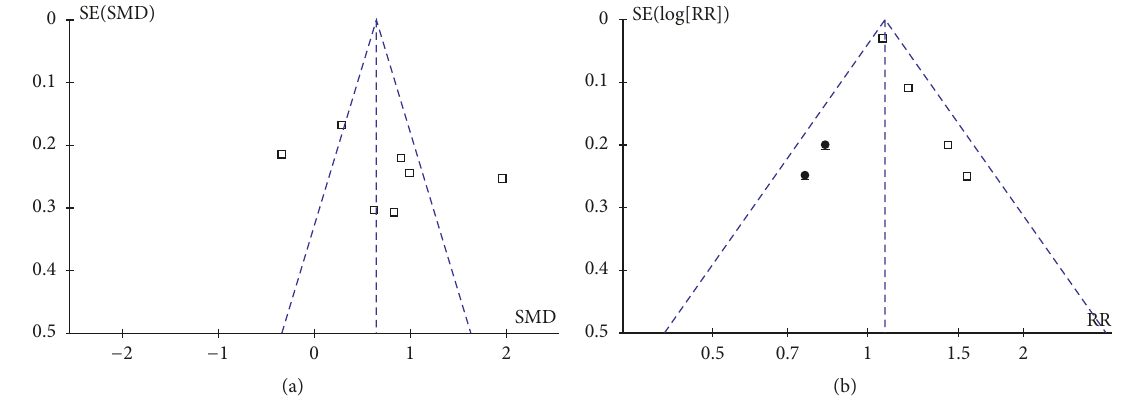
Figure 3: Funnel plots showing estimated publication biases. (a) Funnel plots for the differences in baseline Gal-3 levels in patients with and without AF recurrence; (b) funnel plots with “trim-and-fill” analysis for the predictive efficacy of baseline Gal-3 levels for determining the risk of AF recurrence after catheter ablation. Black dots indicate imputed